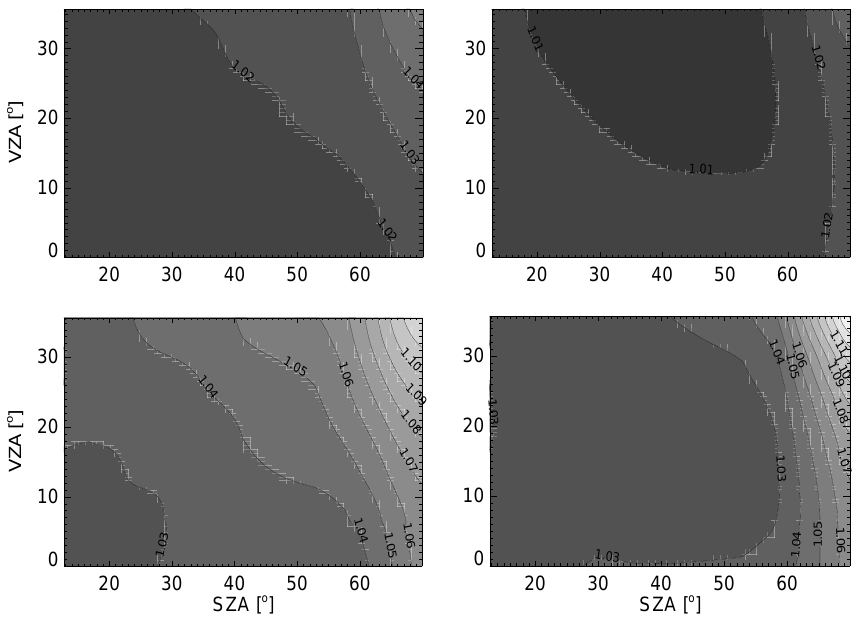
Fig. 5. Scattering correction factor f as a function of viewing and illumination geometry for relative azimuth angle of 180 ◦ (left panels) and 0 ◦ (right panels), with 0 ◦ representing cases where the sensor is placed opposite of the sun, shown for aerosol optical thickness of 0.28, a surface albedo of 0.4, TCWV of 56mm and a continental aerosol located in the boundary layer (upper panels) and the upper troposphere (lower panels), respectively.